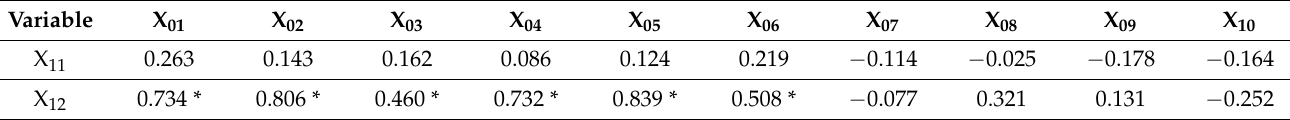
Table 7. Correlations of energy consumption (variables X 01 –X 06 ) and renewable sources of energy (variables X 07 –X 10 ) with environmental impacts in the form of greenhouses gas emissions from energy (X 11 ) and economic conditions (X 12 ) in EU (27) countries in 2019.